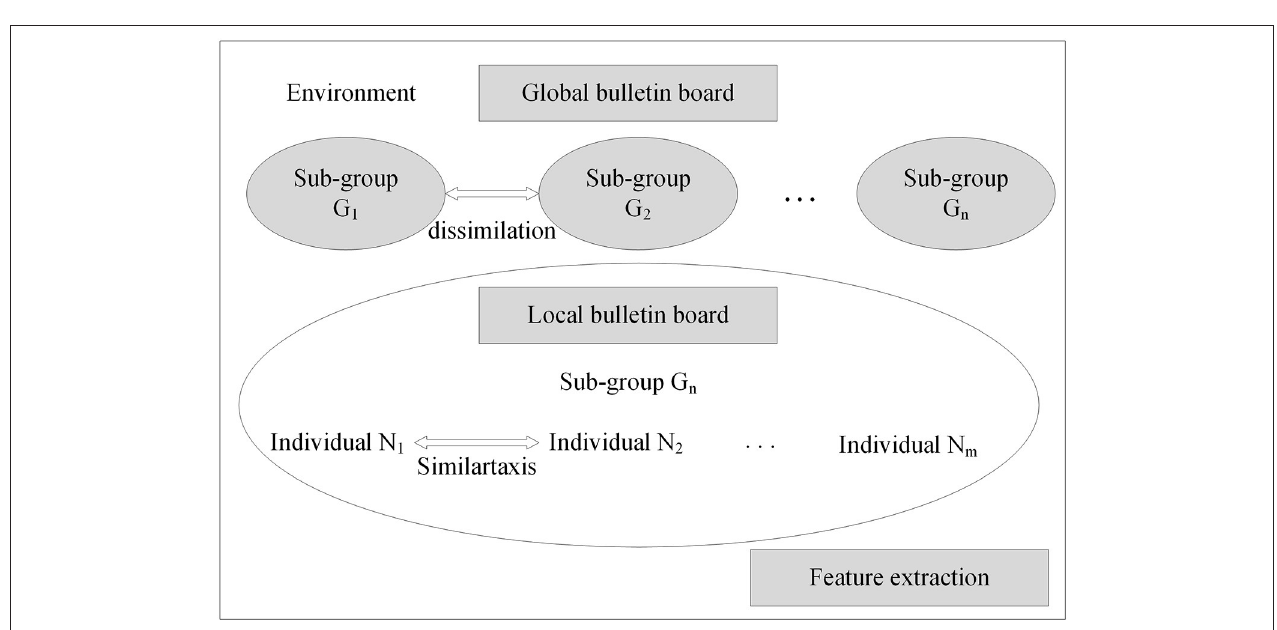
FIGURE 2 | Structure of a neural network.